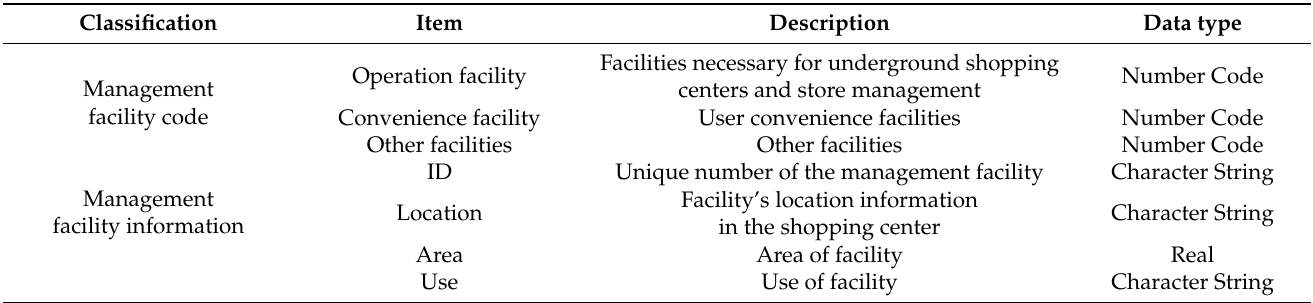
Table A3. Attribute specification of management facility